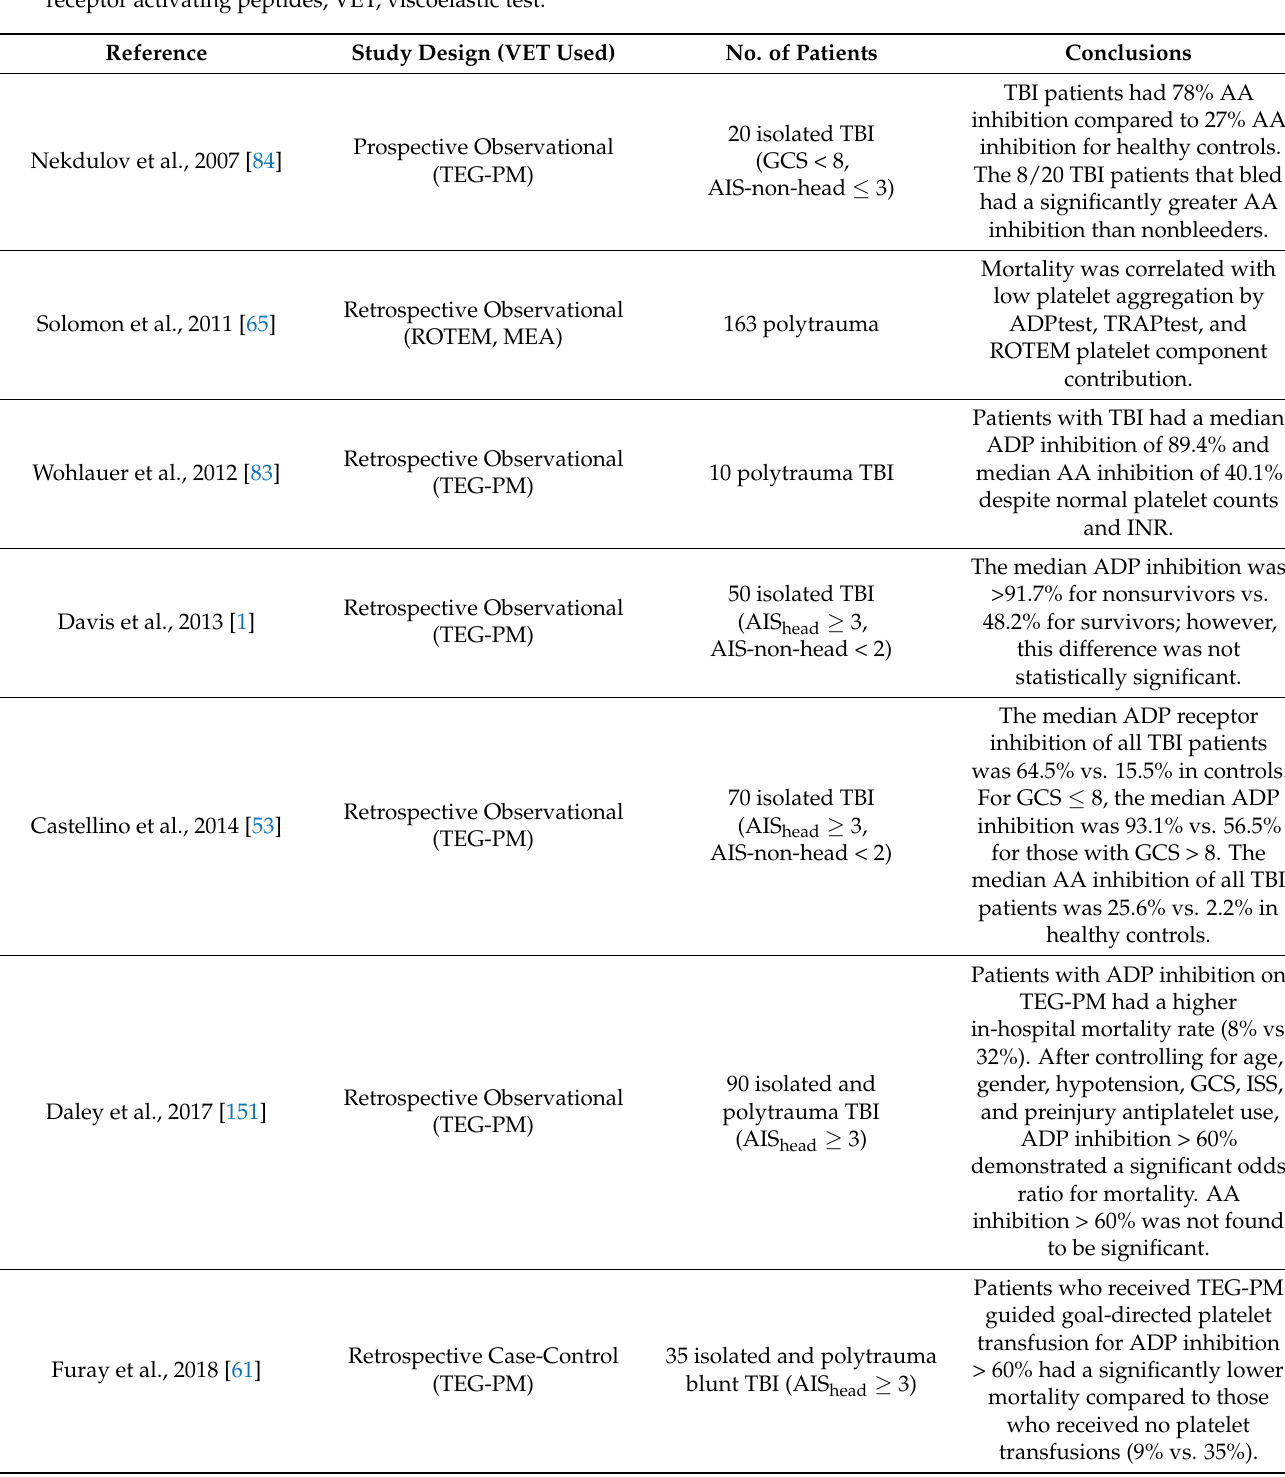
Table 1. Studies using modified VETs or VETs with adjunctive platelet function analyses in TBI. AA, arachidonic acid; ADP, adenosine diphosphate; AIS head , abbreviated injury severity score, head; DDAVP, desmopressin; GCS, Glasgow Coma Scale; INR, international normalized ratio; ISS, injury severity score; MEA, multiple electrode aggregometry; ROTEM, rotational thromboelastometry; TBI, traumatic brain injury; TEG-PM, thromboelastography with platelet mapping; TRAP, thrombin receptor activating peptides; VET, viscoelastic